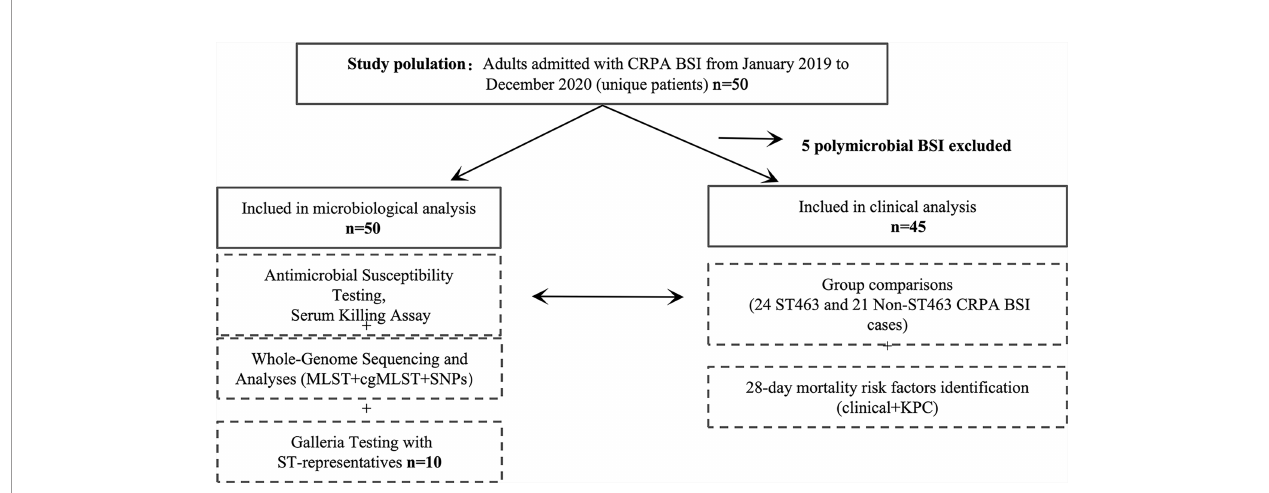
FIGURE 1 | Study design. BSI, bloodstream infection; MLST, mulitilocus sequence typing; cgMLST, core genome MLST; SNPs, single nucleotide